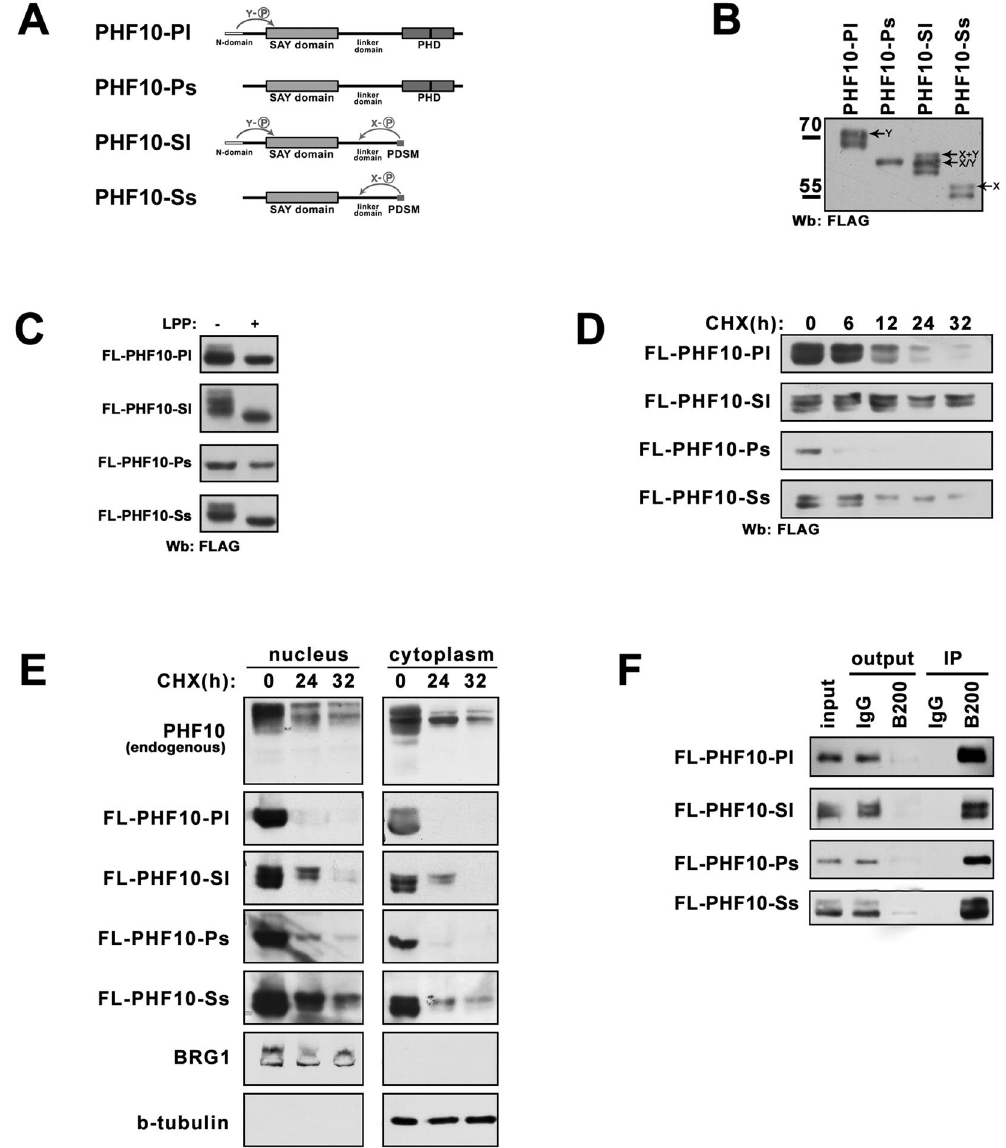
Figure 2. The correlation between stability and phosphorylation of PHF10 isoforms. ( A ) The schematic representation of domain structure and phosphorylation patterns of PHF10 isoforms. N-terminal domain, SAY- domain, linker domain and double PHD or PDSM domains are indicated. N- terminal domain is characteristic for the PHF10-Pl and PHF10-Sl isoforms and determines their Y- phosphorylation pattern. The absence of PHD domains on C- terminus of PHF10-Sl and PHF10-Ss isoforms determines their X-phosphorylation. ( B ) Western blot of FLAG-tagged PHF10 isoforms overexpressed in HEK293. Protein bands corresponding to X- and Y-phosphorylated isoforms are indicated by arrows. ( C ) HEK293 cells transfected with FLAG-PHF10 isoforms. 15 µ g of total protein extract were either treated with lambda protein phosphatase (LPP) or left untreatead, and then analyzed by Western blotting ( D ) HEK293 cells transfected with FLAG-PHF10 isoforms were treated with 20 µ g/ml CHX for time points indicated above the panels. 15 µ g of total protein extract was loaded per well and analyzed by Western blotting. ( E ) Wild type HEK293 cells or HEK293 cells transfected with FLAG-PHF10 isoforms were treated with CHX (20 µ g/ml) for different time. After incubation the cells were fractionated into cytoplasmic and nuclear fractions. Protein extracts were analyzed by Western blotting using antibodies against endogenous PHF10 or against FLAG tag. BRG1 and β -tubulin were used as fractionation and loading control. ( F ) The immunoprecipitation (IP) of FLAG-tagged PHF10 from nuclear extract of HEK293 with antibodies against BAF200(B200 in Fig. 2F). The immunoprecipitation demonstrates that all PHF10 is depleted together with BAF200 and thus is associated with PBAF complex. The ½ of precipitates and 1/10 of the Input and Outputs was loaded on the gel. The images in Fig. 2(B,C,D,E, F) are